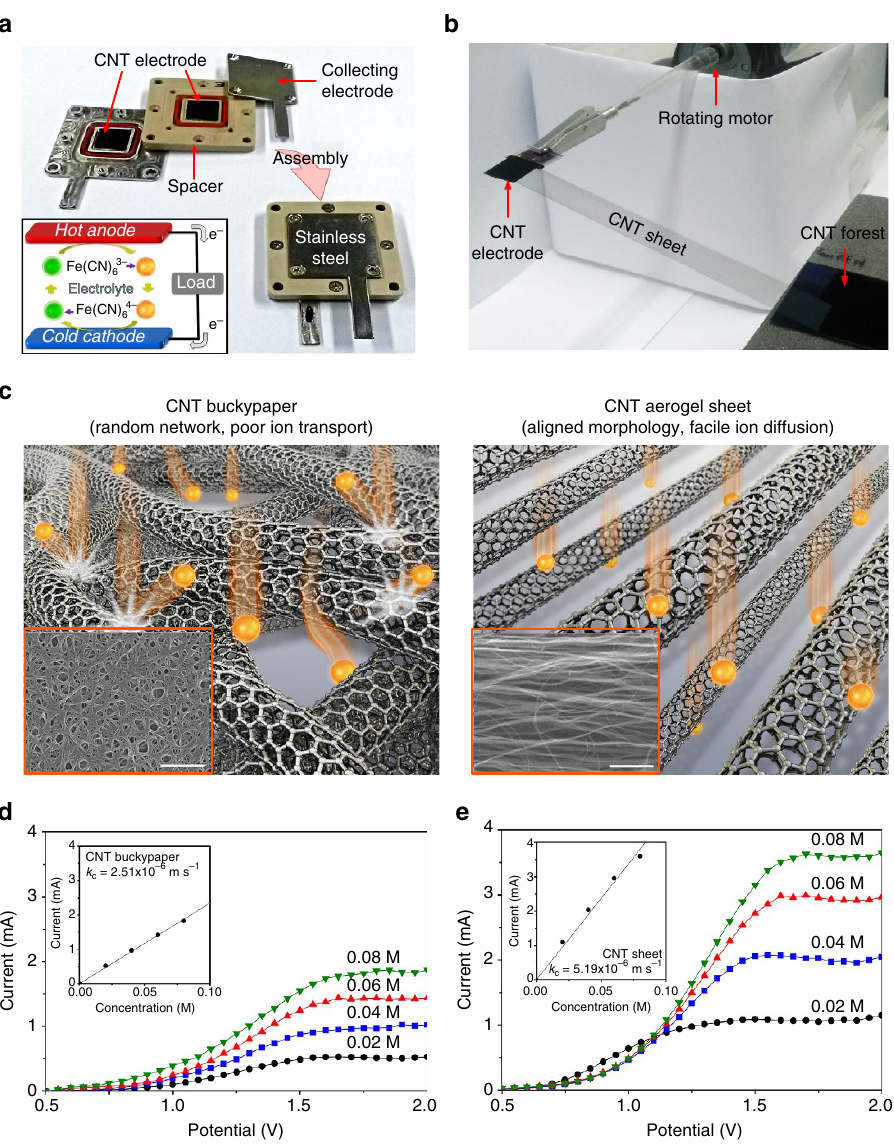
Figure 1 | Carbon nanotube aerogel sheets as high-performance electrodes. ( a ) Photographs of cell components and their assembly into a planar thermocell (inset: schematic drawing of thermocell operation). ( b ) An apparatus for continuously drawing a carbon nanotube (CNT) aerogel sheet from a CNT forest, and wrapping it around a metal frame to form an electrode for a planar thermocell. ( c ) Illustrations and SEM micrographs (insets) comparing CNT buckypaper and CNTaerogel electrodes and the relationship of these morphologies to ion transport (scale bars in the insets, 1- m m). MWNT bundling is not shown and only MWNTouter walls are pictured. Polarization curves for ( d ) CNT buckypaper and ( e ) CNTaerogel electrodes. The insets show the dependence of limiting current on ferrocyanide aerogel sheet (5.19 (cid:3) 10 (cid:2) 6 m s (cid:2) 1 ) is estimated to be twice that of CNT buckypaper (2.51 (cid:3) 10 (cid:2) 6 m s (cid:2) 1 ). The transfer coefficient of CNT aerogel sheet electrode approaches the theoretically limiting mass transfer coefficient (5.76 (cid:3) 10 (cid:2) 6 m s (cid:2) 1 , see